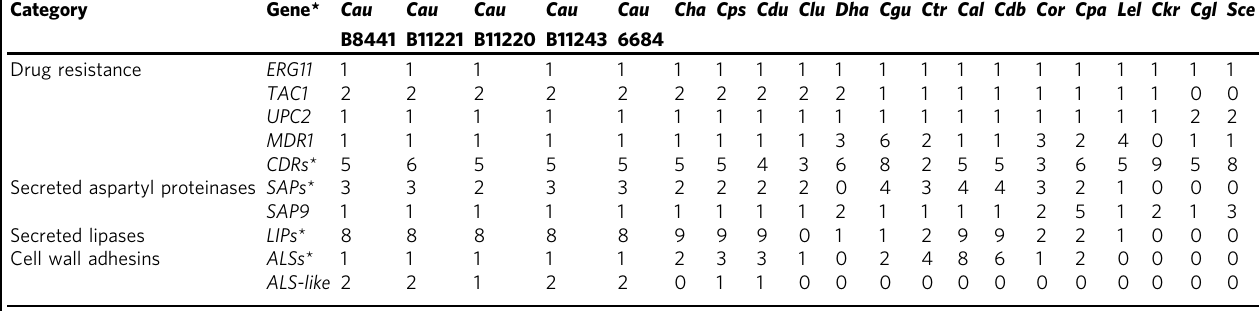
Table 2 Conservation of genes involved in pathogenesis and drug resistance